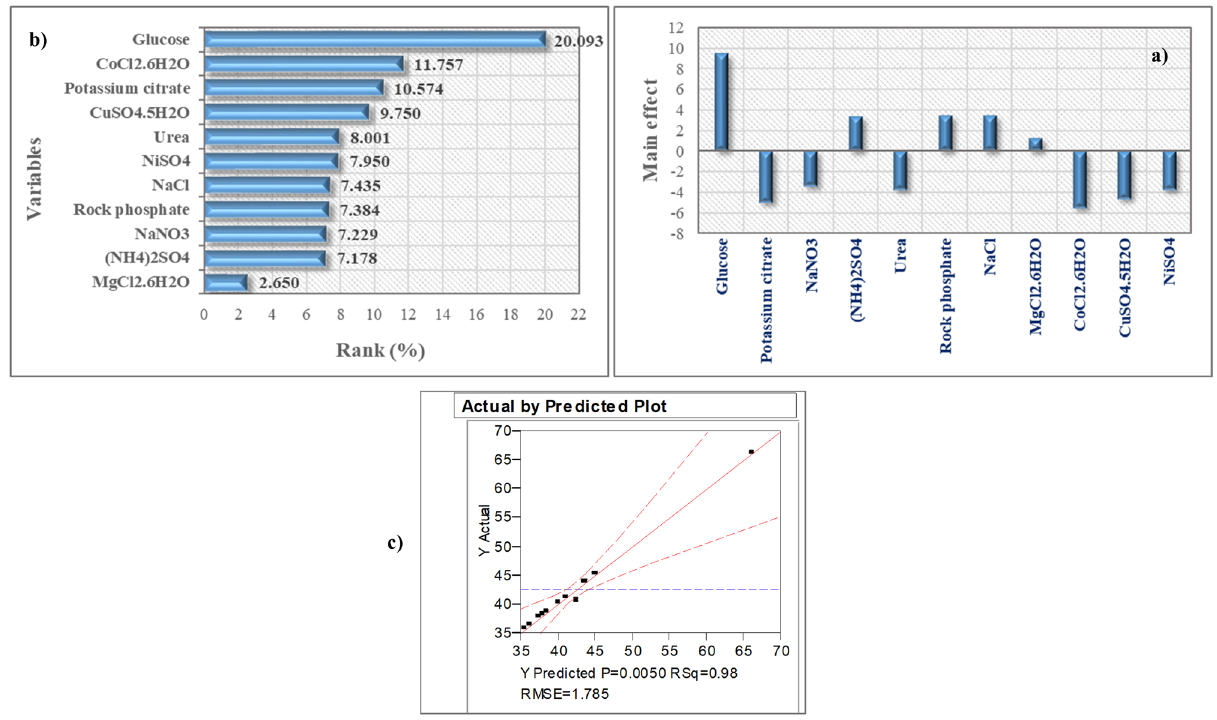
Figure 3. Plackett–Burman design results, (a) main effect chart of culture variables, (b) Pareto chart illustrating the order and significance of the variables affecting ACP production by B. haynesii strain ACP1 in a ranking percentage from 2.650 to 20.093, and (c) normal probability plot of the residuals for acid phosphatase production determined by the first-order polynomial